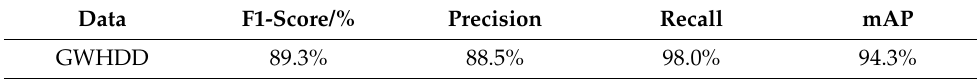
Table 3. Evaluation indicators of wheat ear detection.